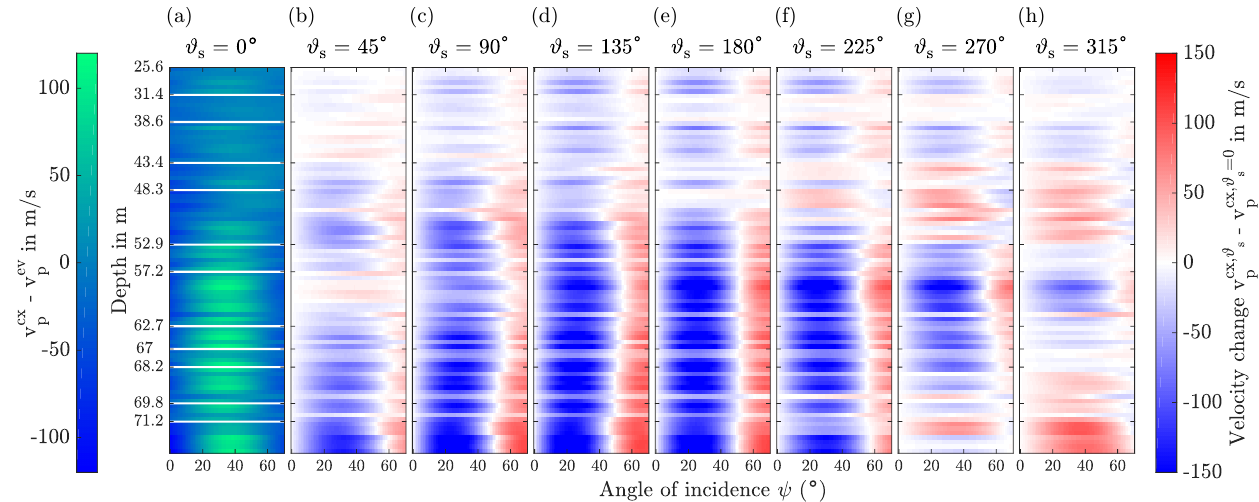
Figure 8. (a) Difference in KCC seismic P-wave velocity between cx and ev framework ( v cx p − v ev p ) for incidence angles up to 70 ◦ . (b–h) Change in P-wave velocity as calculated with cx framework for different seismic plane azimuth angles ϑ s compared to ϑ s = 0 ◦ ( v cx,ϑ s p − = 0 cx = [− 194 , 109 ] ms − 1 ) lie in the saturated range of the − v cx,ϑ s = 0 − v ev = [± 185 ] ms − 1 and v cx,ϑ s v cx,ϑ s p p p ). The extreme values ( v p p colour scale, providing a better visual contrast (see Table 2). Note the breaks in the depth axis where noted depth values refer to the top of the downward-extending depth interval.